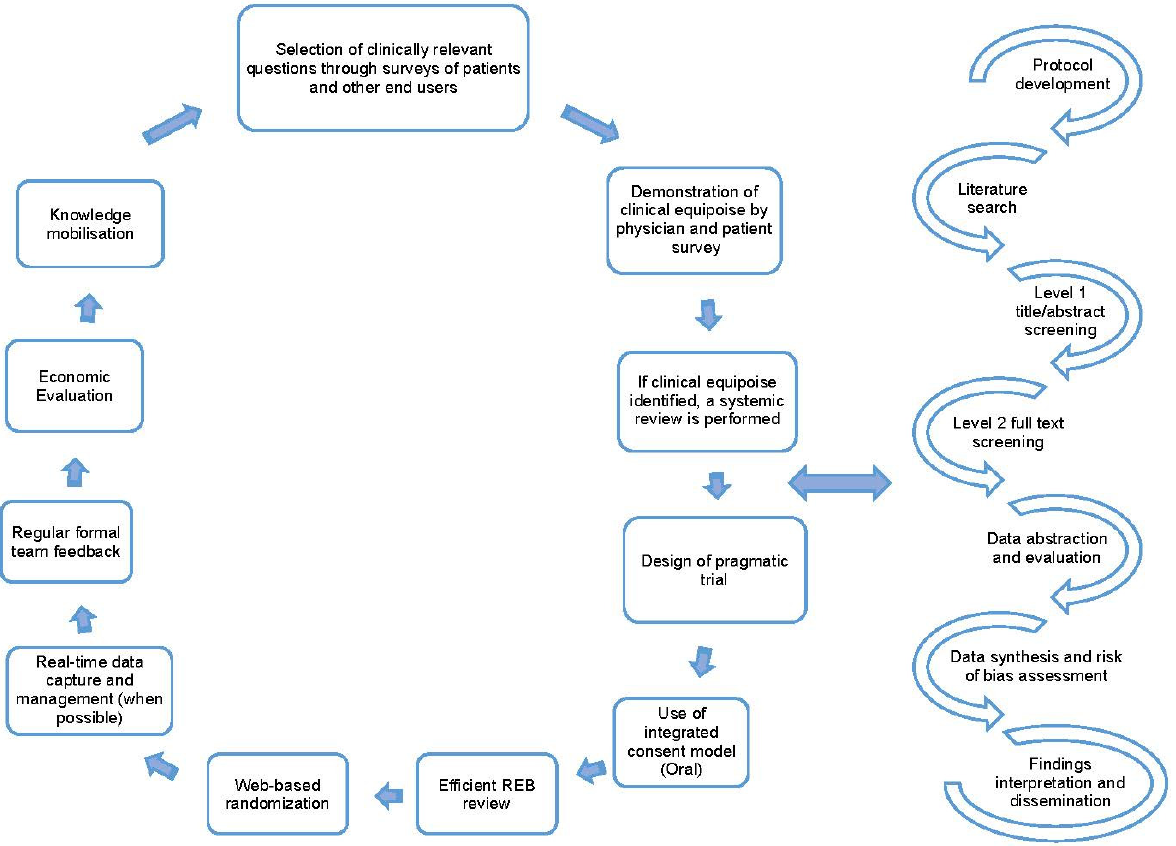
Figure 1. Key tenants for the REaCT Program; adapted with permission from [1,8] and the road map for systematic reviews.